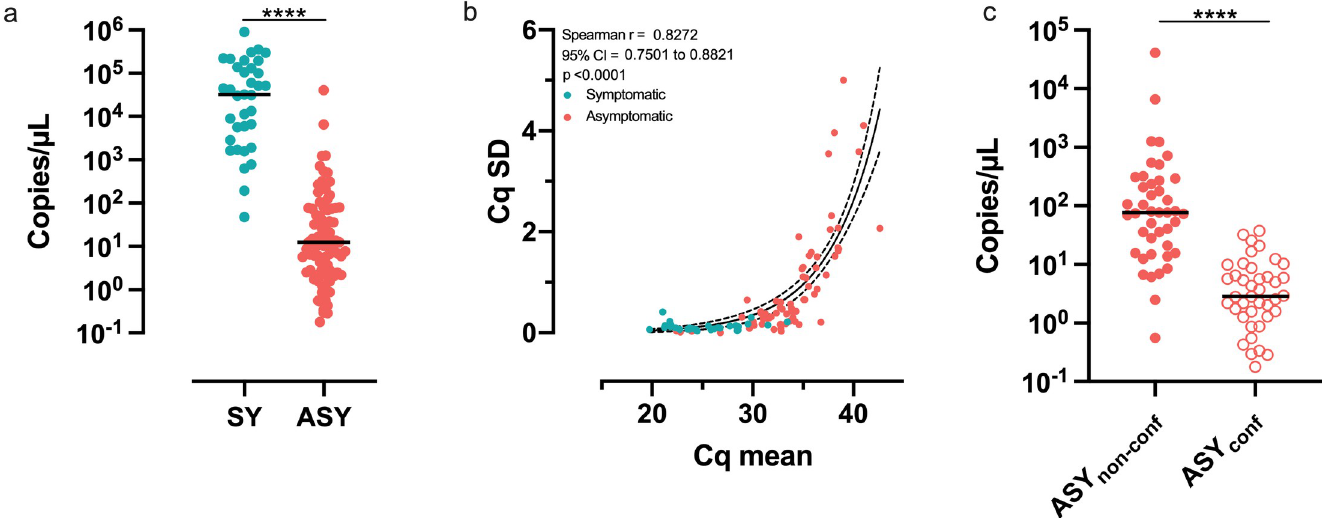
Fig 3. Asymptomatic infections with Pv are characterized by lower parasitemia compared to symptomatic patients. (a) Estimated parasitemia determined by qPCR. Asymptomatic infections are characterized by very low parasitemia. Each dot represents the average number of copies/ μ L of an individual in at least 3 replicates. (b) Correlation between mean Cq value and correspondent standard deviation. High Cq values correlate with higher variation in the measurement. (c) Several asymptomatic infections had conflicting PCR results (ASY conf ); 1 or more negative results in qPCR. Asymptomatic non-conflicting (ASY non-conf ) individuals had all qPCR replicates positive. Each dot represents the average number of copies/ μ L estimated from the Ct of the positive replicates of a subject, in at least 3 replicates. Bars amid dot plots represent the respective means. ���� p < 0.0001. t-Student test. SY–Symptomatic patients. ASY–Asymptomatic individuals.